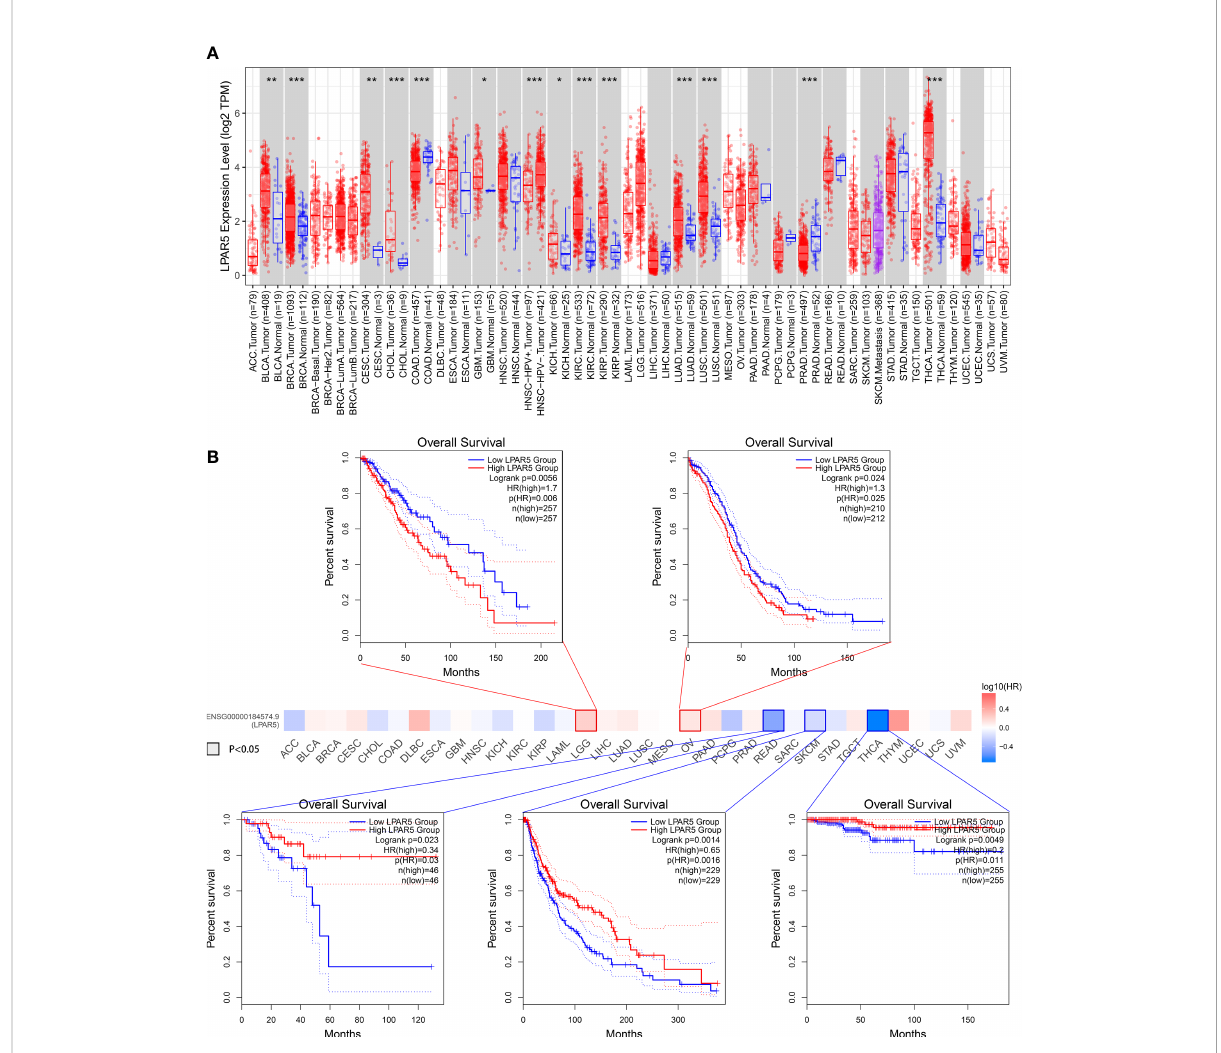
FIGURE 13 Pan-cancers analysis. (A) LPAR5 expression in pan-cancers. (B) Survival analysis in pan-cancers. *: P<0.05; **: P<0.01; ***: P<0.001; ns, not signi fi